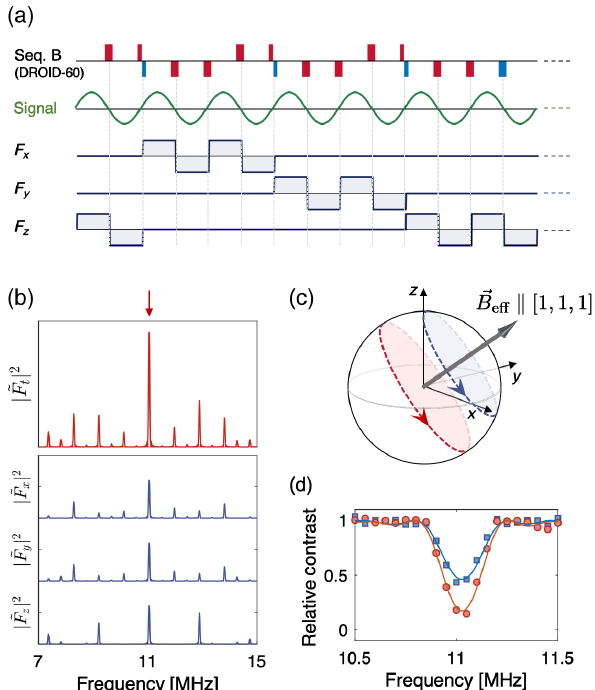
FIG. 3. Optimal sensing with unconventional spin state prepa- ration. (a) Pulse sequence (top row) and three-axis time-domain modulation functions (blue solid curves) for the first 14 free- evolution times of DROID-60. Red and blue bars in DROID-60 indicate rotation pulses as defined in Fig. 2(a). The modulation period along each axis is synchronized to an ac sensing signal (green curve). (b) Frequency-domain modulation function j ˜ F ð f Þj 2 for DROID-60, with pulse spacing τ ¼ 25 ns and x;y;z π -pulse width τ ¼ 20 ns. The total strength j ˜ F ð f Þj 2 is obtained π t ˜ F ð f Þ considering their from individual axis amplitudes x;y;z relative phases in the frequency domain [17]. The principal resonance is highlighted by a red arrow, yielding maximum sensitivity. (c) Illustration of the effective magnetic field created by DROID-60 at the principal resonance. In the average Ham- iltonian picture, the ˆ z -direction sensing field in the external ⃗ B reference frame transforms to the [1,1,1]-direction field in the eff effective spin frame with a reduced strength [17]. Optimal sensitivity is achieved by initializing the spins into the plane perpendicular to the effective magnetic field direction. This optimal state preparation allows the spins to precess along the trajectory with the largest contrast (red dashed line). For comparison, the precession evolution for initialization to the conventional ˆ x axis is shown as a blue dashed line. (d) Sensing resonance spectra near the principal resonance. The optimal initialization (red) shows greater contrast than the ˆ x -axis initial- ization (blue). Markers indicate experimental data and solid lines denote theoretical predictions calculated from the frequency- domain modulation functions